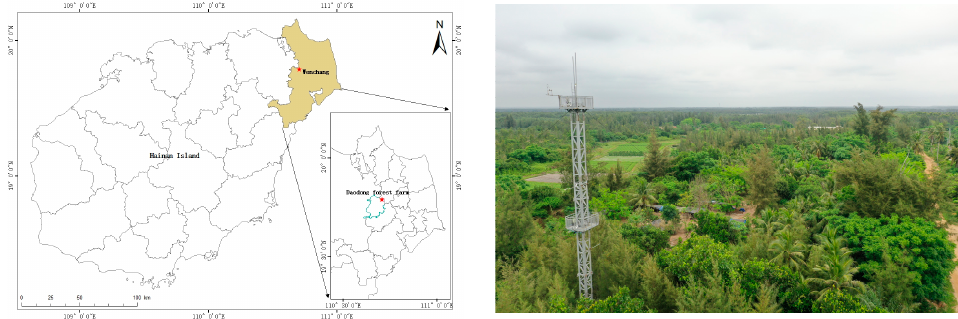
Figure 1. Geographic Location of Study Site ( left ); images in study region ( right ).